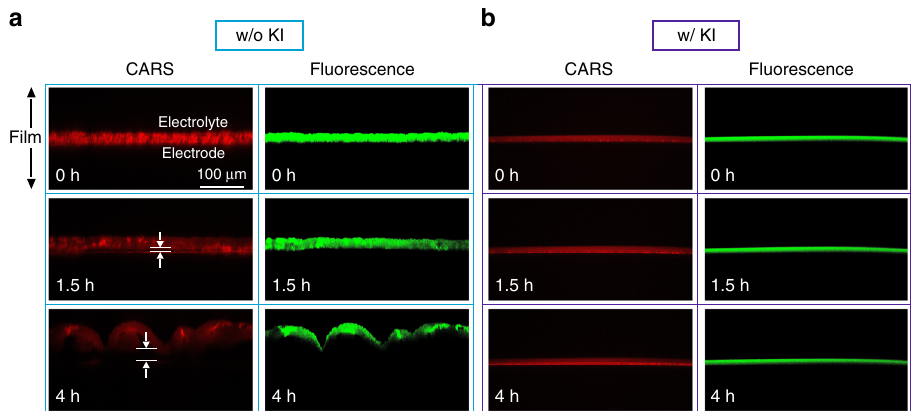
Fig. 4 Confocal microscopy study of the viologen-modi fi ed fi lm degradation. Coherent anti-Stokes Raman scattering (CARS) and confocal fl uorescence microscopy a in the absence and b in the presence of KI (0.1 M). A constant potential of − 0.1 V vs SHE was applied to the electrodes in the presence of air to generate H 2 O 2 . CARS images show Raman intensity at 2841 cm − 1 . Fluorescence was recorded between 500 and 630 nm at 488 nm excitation. The arrows in the CARS images (1.5 and 4 h) highlight the gap between the fi lm and the electrode surface. For all experiments, the GCE (3 mm in diameter) were coated with viologen-modi fi ed polymer with a surface coverage of 2.2 mg cm − 2 . Electrolyte: phosphate buffer (0.1 M, pH 7). The scale is the same for all images. These images are part of a longer time-resolved measurement available as a video fi le (Supplementary Movies 1 –